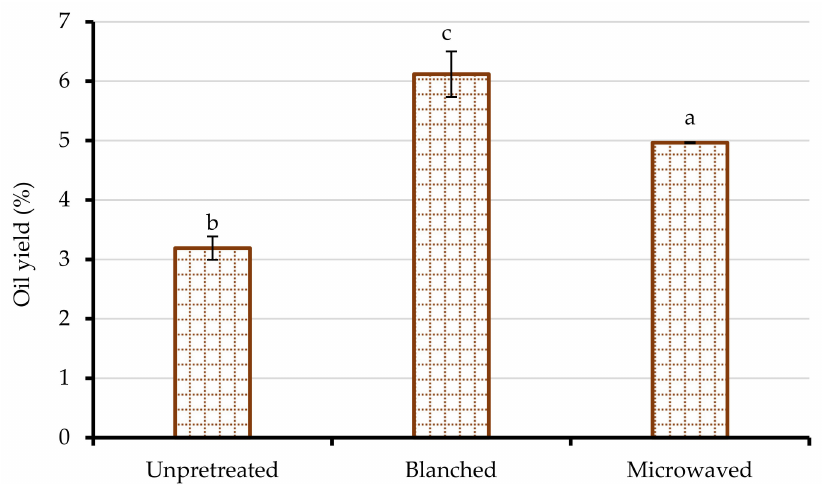
Figure 1. Oil yield of cold-pressed pomegranate seed oil from unpretreated, blanched (95 ± 2 ◦ C/3 min), and microwave-heated (261 W for 102 s) seeds. Columns followed by different letters are significantly different ( p < 0.05) according to Duncan’s multiple range test. Vertical bars indicate the standard deviation of the mean. Table 1. Physicochemical properties of cold-pressed pomegranate seed oil (PSO) from unpretreated, blanched (95 ± 2 ◦ C/3 min), and microwave-heated (261 W for 102 s) seeds. Treatment RI